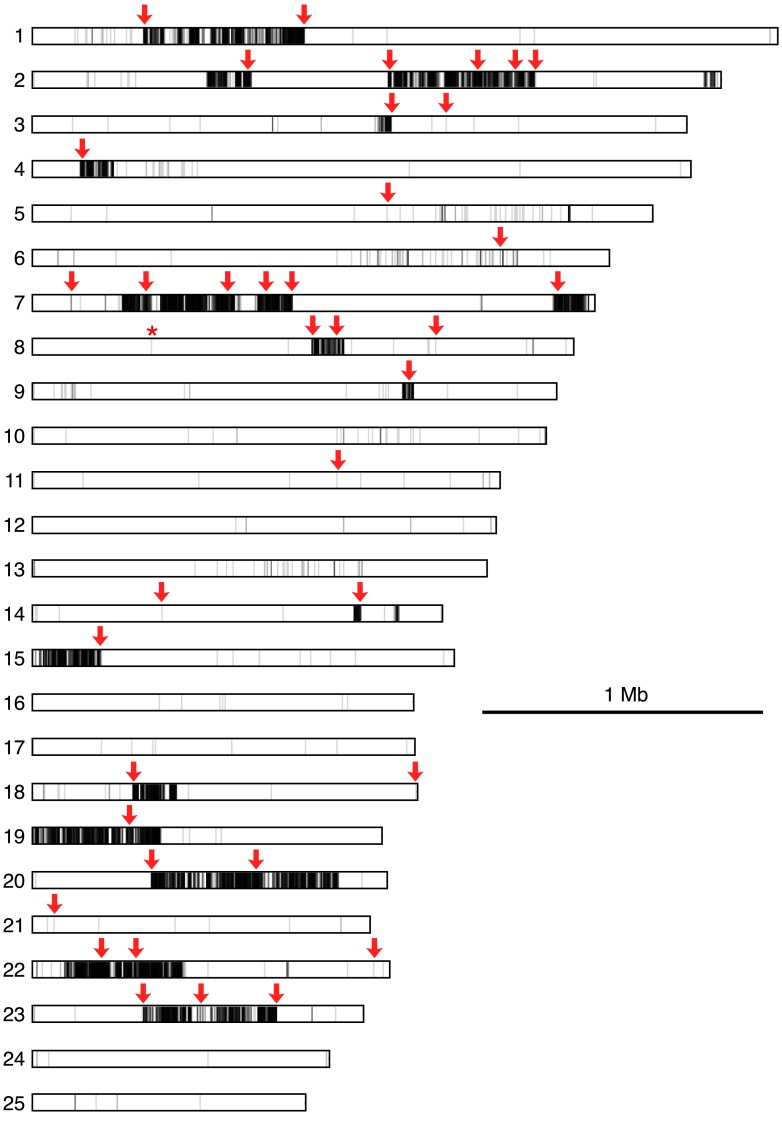
Map of polymorphisms and markers used in the cross.Horizontal bars represent the 25 largest supercontigs in the S. rosetta genome. The positions of each predicted polymorphism, based on comparisons of the genome sequences of Rosetteless and Isolate B, are vertical lines mapped semi-transparently in black, such that regions with high variant density are darker than those with lower variant density. Red arrows show positions genotyped in all cross isolates, including the perfectly linked supercontig 8: 427,804 mutation (*, Figure 4—source data 1). Note that the supercontig 8: 427,804 mutation lies within a haplotype block with little to no polymorphism between Rosetteless and Isolate B.